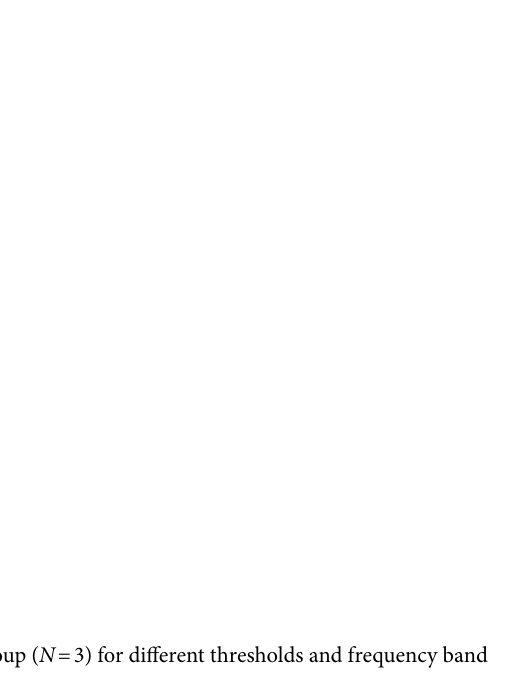
Table 1. Repeated measures ANOVAs in experimental groups ( N = 13) for different thresholds and frequency band definitions.